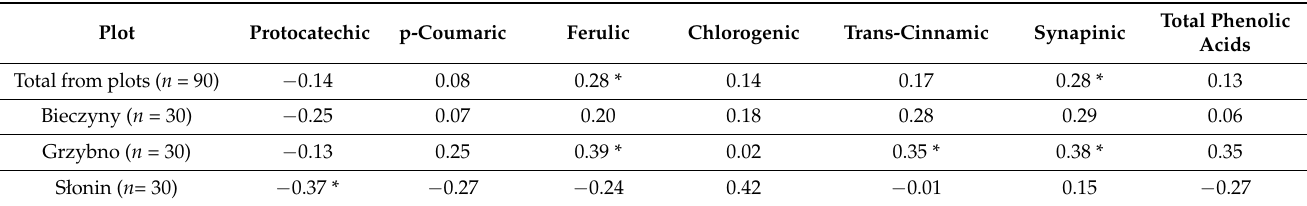
Table 7. The Spearman’s rank correlation coefficients between the extent of foraging in the evaluated plots vs. concentration of selected phenolic acids in willow. * Significant at p <